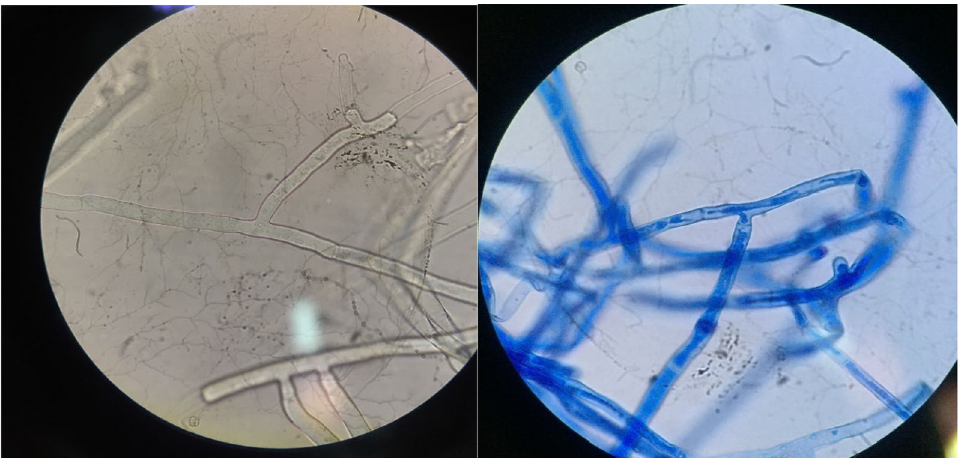
Fig. 2 Microscopic images showing typical hyphal characters of Rhizoctonia solani (Tended to branch at right angle and constriction at base) under